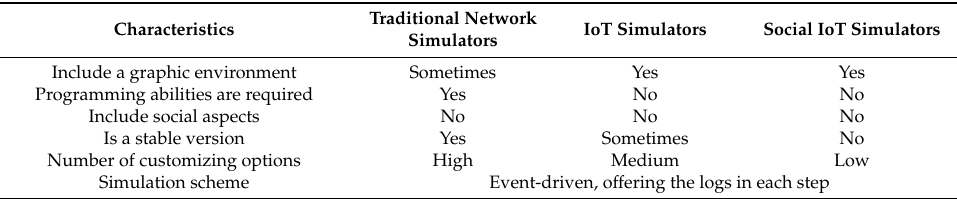
Table 4. Network or IT simulators